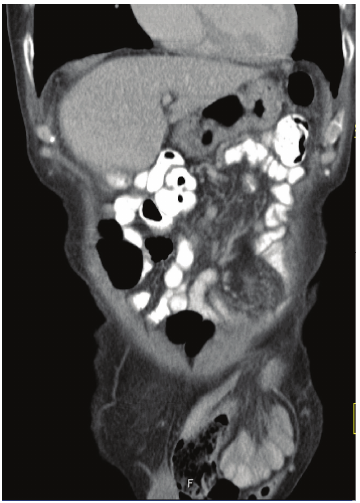
Figure 2: Coronal CT showing herniation of colon and mesentery through the inguinal canal.